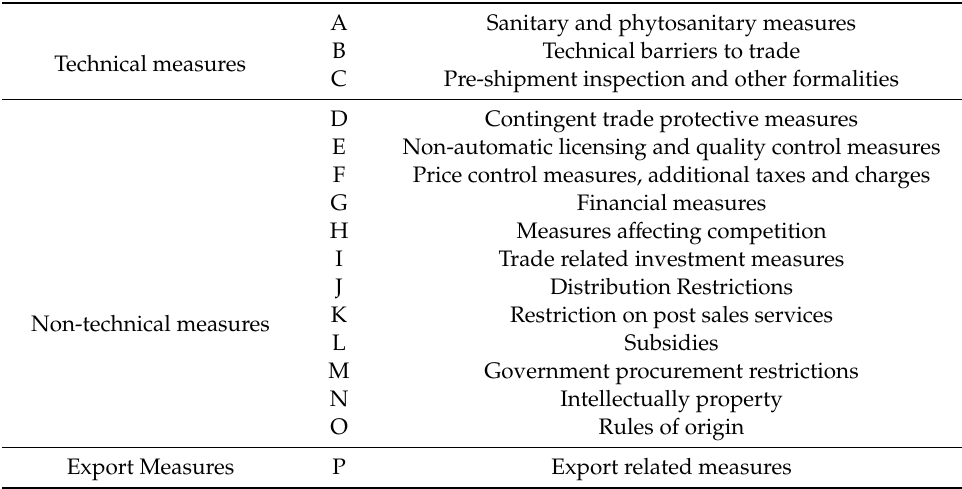
Table 1. Structure of non-tari ff measures